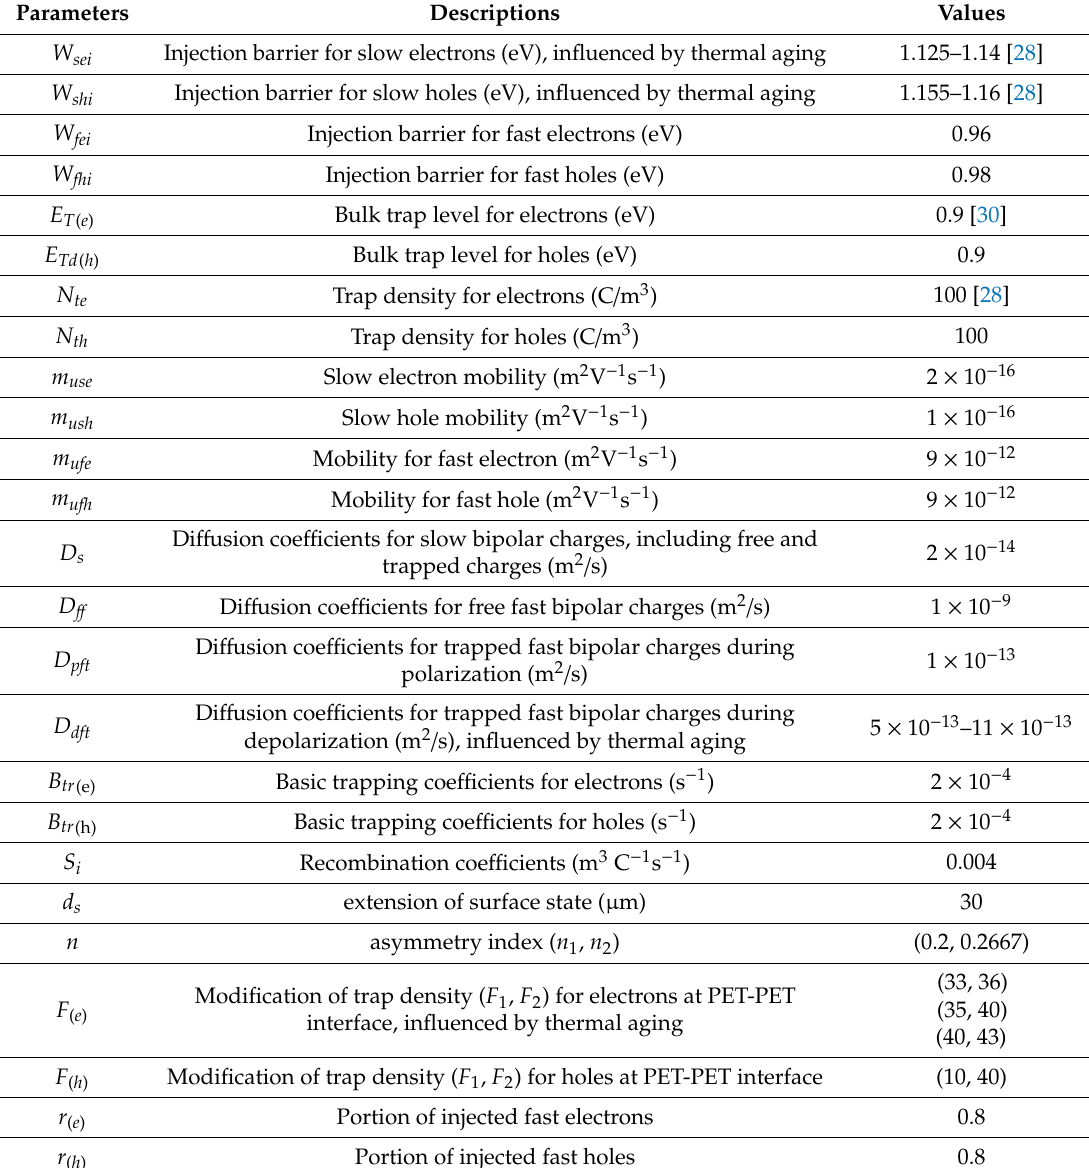
Table 2. Definition of the modeling parameters. When the influence of thermal aging is considered, several parameters are provided within a certain